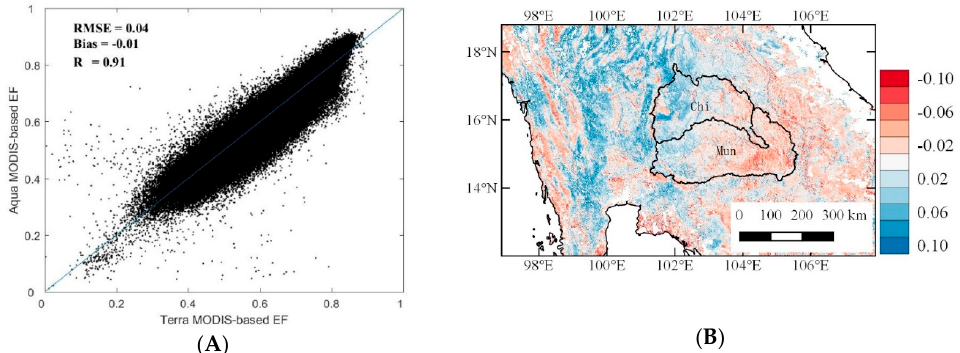
Figure 6. Comparison of EF based on Terra and Aqua MODIS on January 20 of 2009. ( A ) scatter plot of EF based on Terra and Aqua MODIS data; ( B ) spatial variation of EF difference (EF based on Terra minus that of the Aqua MODIS data).